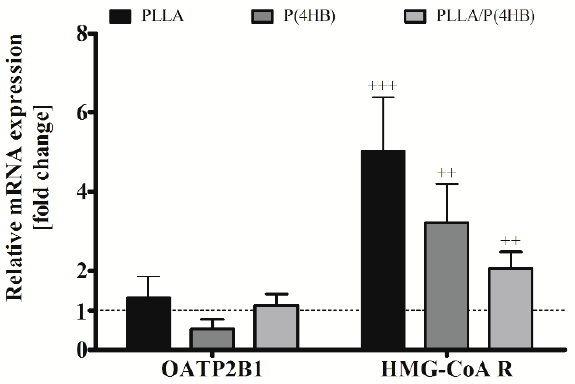
Figure 6. Polymer-dependent gene expression of HCASMC. HCASMC were cultured on control and polymer surfaces for six days. Subsequently, cells were harvested and prepared for quantitative RT-PCR. Bars show mean ± SD of at least six separate experiments normalized to the Thermanox™ (Thermo Fisher Scientific, Darmstadt, Germany) control (dotted line) ( ++ p < 0.01 and +++ p < 0.001).